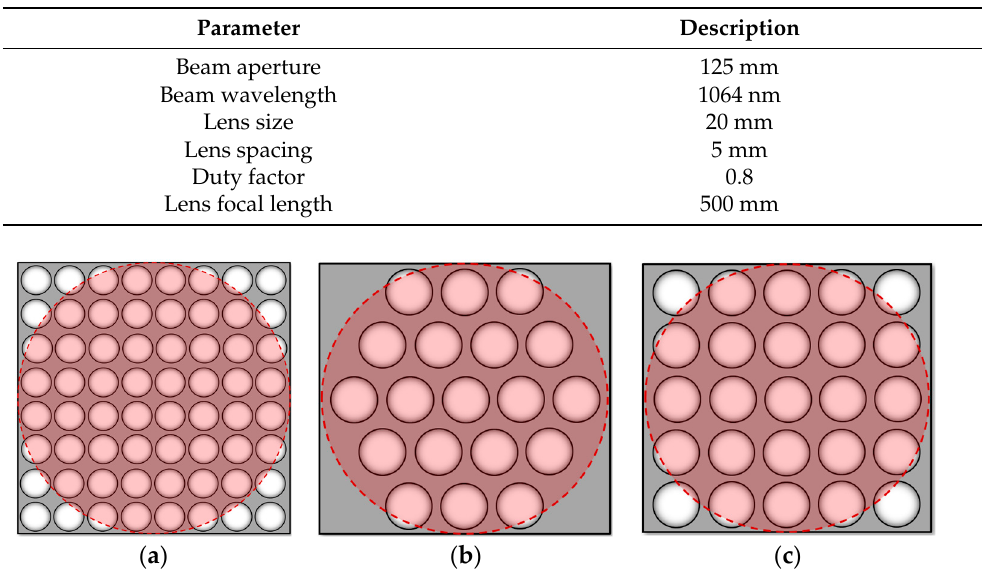
Table 1. System input parameters.